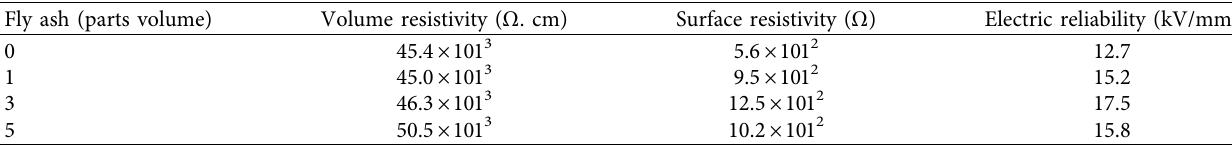
Table 7: Dielectric properties, reliability strengths, and surface resistivity of epoxy and its nanocomposites. Fly ash (parts